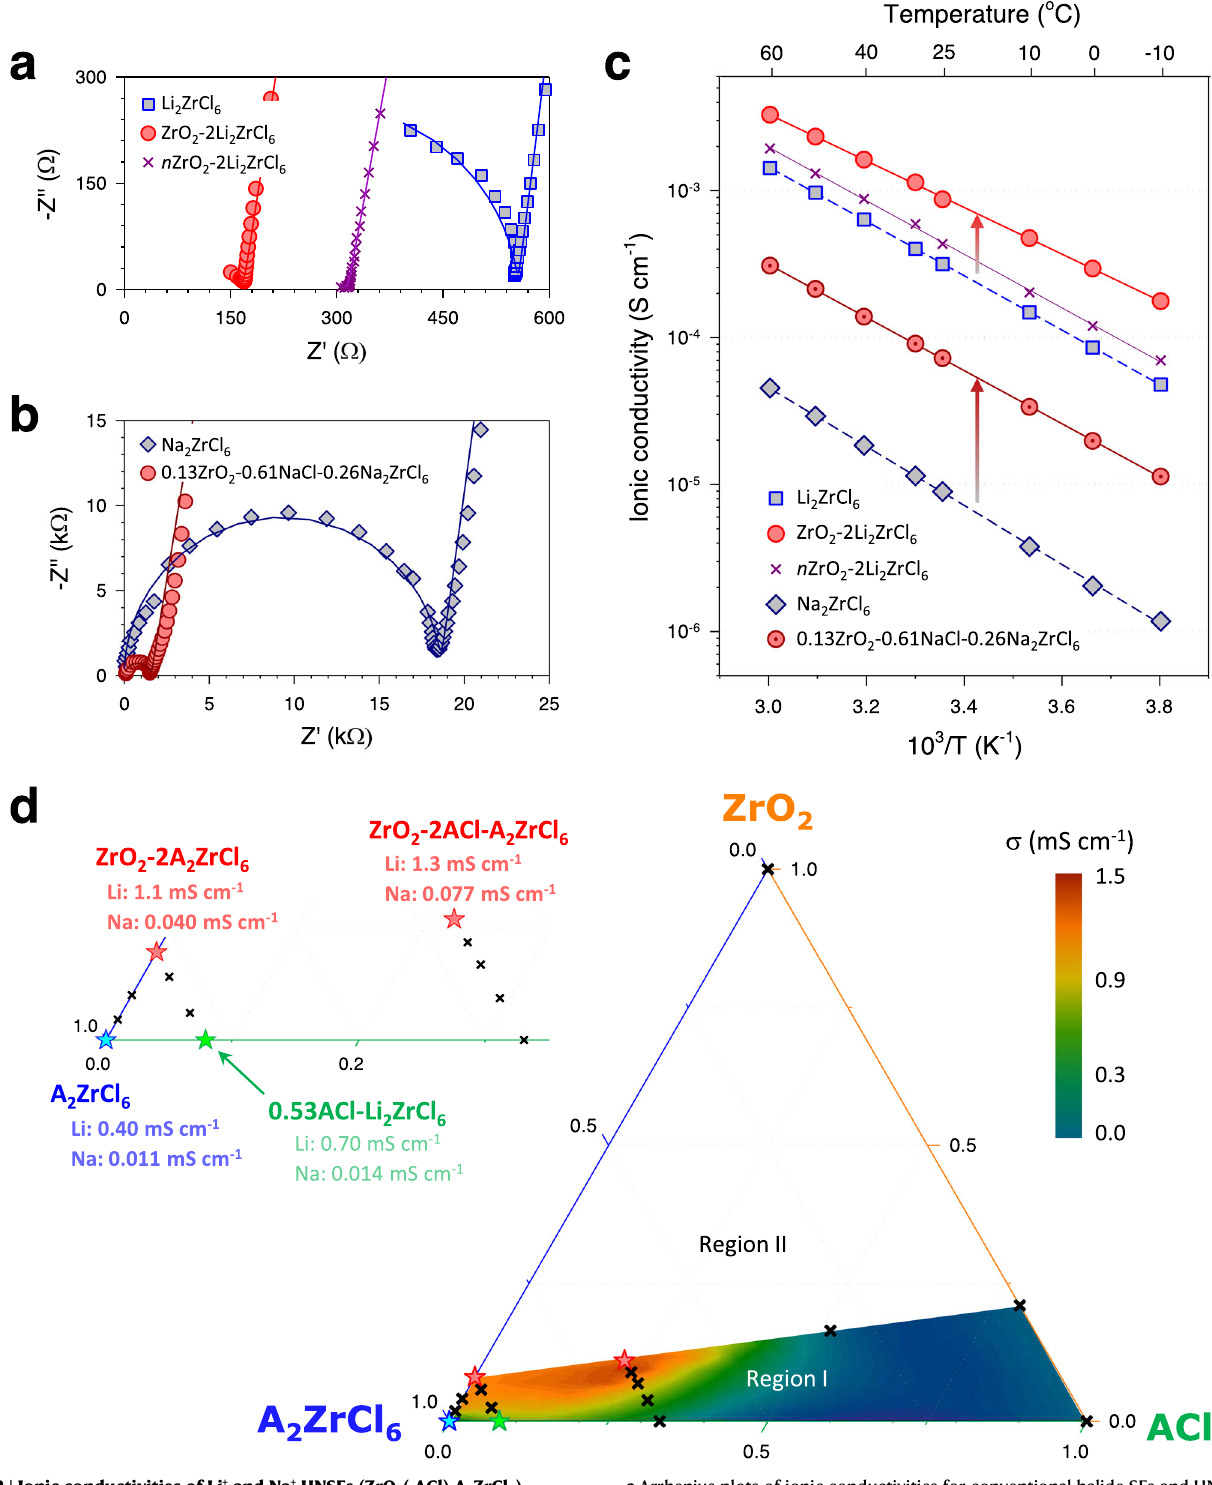
c Arrhenius plots of ionic conductivities for conventional halide SEs and HNSEs. d Ionicconductivitycontourplotat30°CforternaryZrO 2 -ACl-A 2 ZrCl 6 HNSEs.The contour mapwas plottedusing data represented by stars and crosses,with further details provided in Supplementary Tables 5 and